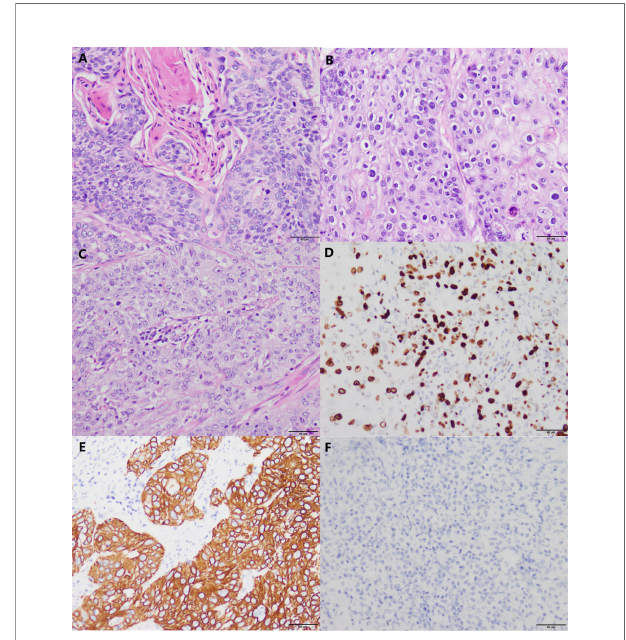
FIGURE 1 | Histomorphologyandimmunohistochemistryinvariably differentiatedESCC(ownimages,havenotbeenpublishedinelsewhere,thescale baris50µm). (A) HighlydifferentiatedESCC(H&Estain,×200). (B) Moderately differentiatedESCC(H&Estain,×200). (C) PoorlydifferentiatedESCC(H&E stain,×200). (D) InthiscaseofpoorlydifferentiatedESCC,thepositiveindexofKi- 67reaches50%(Envisionstain,×200). (E) PoorlydifferentiatedESCCcellsare positiveforCK5/6(Envisionstain,×200). (F) PoorlydifferentiatedESCCcellsare